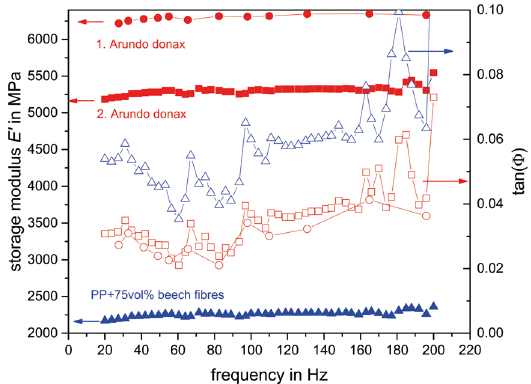
Figure 1. Dependence of the storage modulus E' and loss factor tanΦ of two different samples made of Arundo donax and a polypropylene (PP)-beech fibre composite with 75vol% beech fibers on frequency measured at room